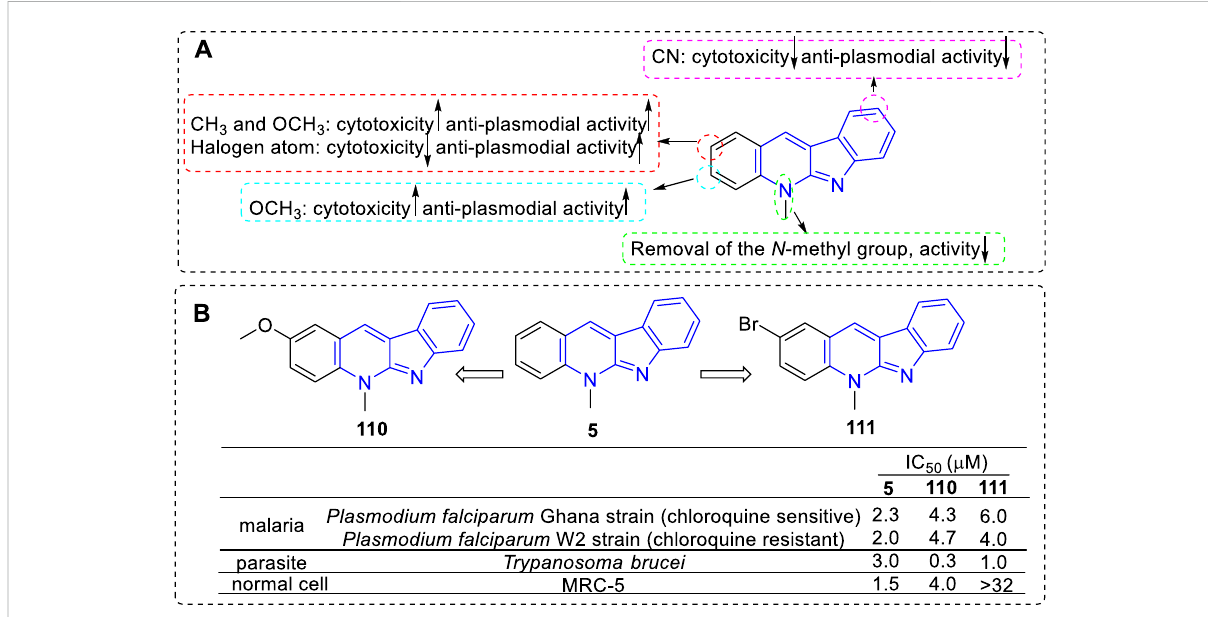
FIGURE 19 (A) SARs of 5 derivatives for their anti-plasmodial activity; (B) Structures and bioactivity of the representative compounds 110 and 111